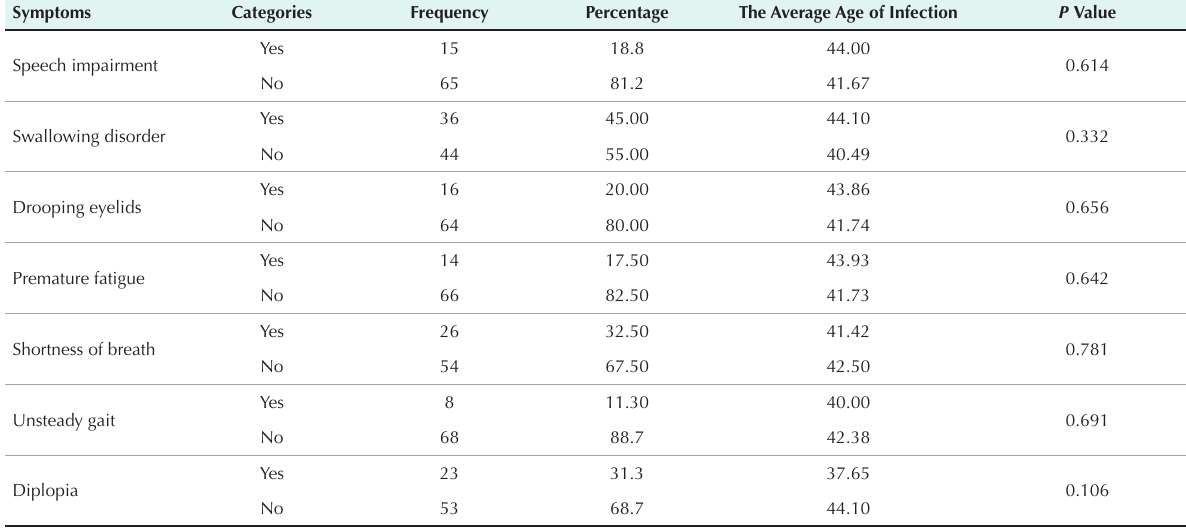
Table 3. The Frequency Distribution of Disease Symptoms and the Average Age of Infection in Patients According to the Symptoms of MG in the Subjects Symptoms